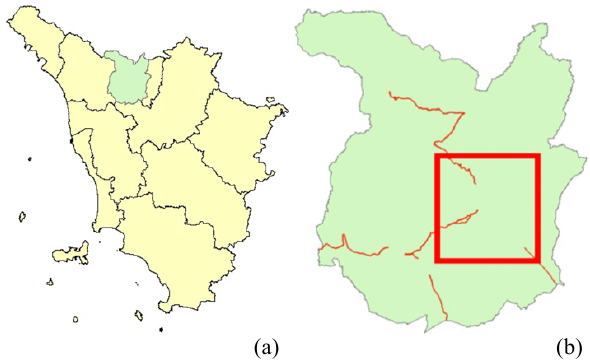
Figure 1. Study Area, (a) the Tuscany Region, (b) the Province of Pistoia and regional two-lane rural